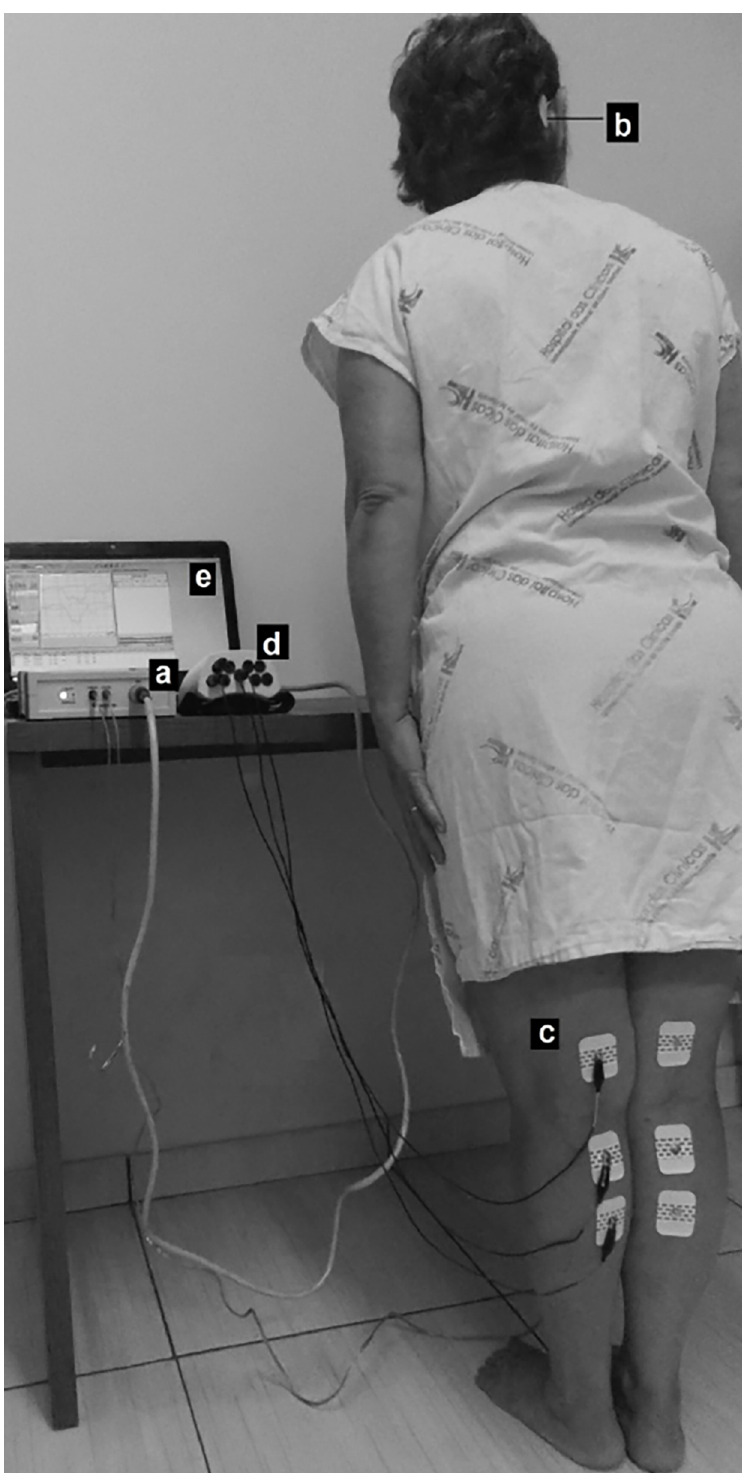
Fig 1. Vestibular-evoked myogenic potential triggered by galvanic vestibular stimulation (galvanic-VEMP) recording positions and equipment. It shows the right position of the participant to capture galvanic-VEMP; the equipment used for stimulus generation (a), the electrode positions for GVS (b), the electrode position to capture an electromyographic response on the gastrocnemius muscle (c), the equipment for processing the signal (d), and the computer for recording the responses